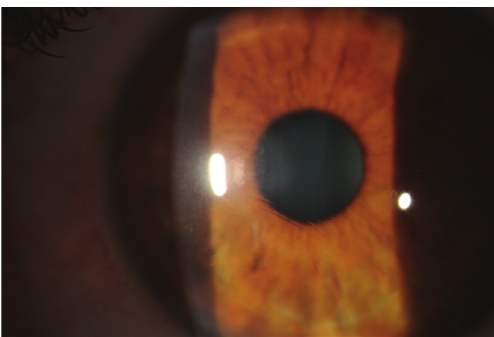
Figure 3: Slit lamp photograph of the injured eye two weeks after surgical correction with only 3 of the original 9 sutures remaining under a bandage contact lens.